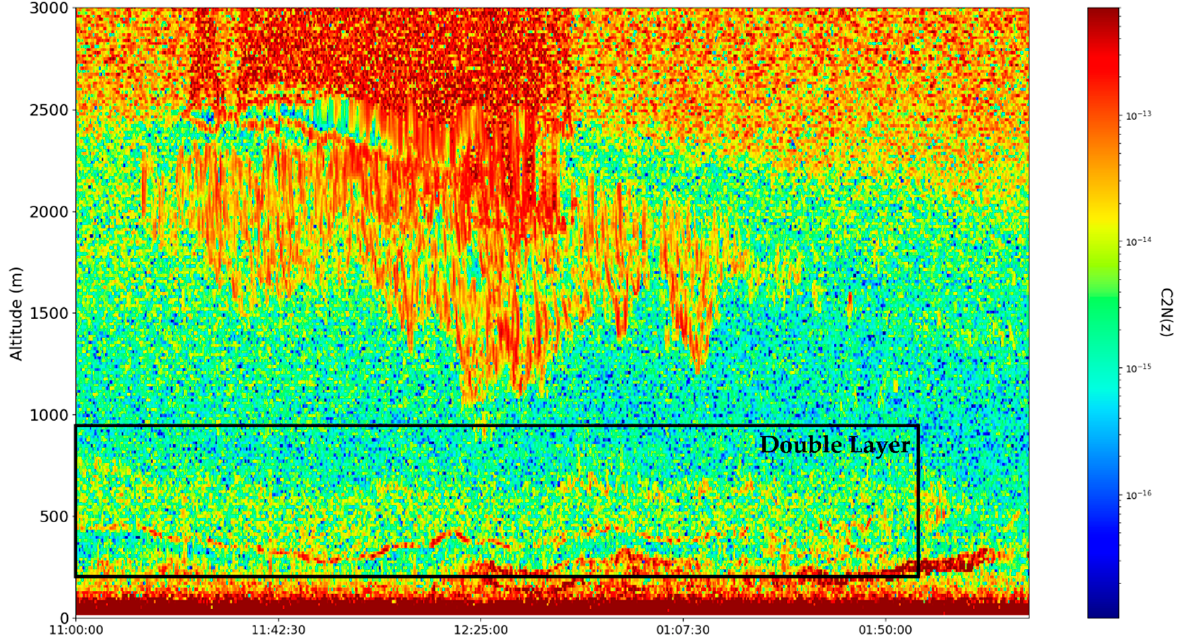
Figure 20. Zoomed-in (region of interest) C (cid:2898)(cid:2870) time series, λ = 1064 nm , Gala ț i, Romania, 22 Decem- ber 2021.